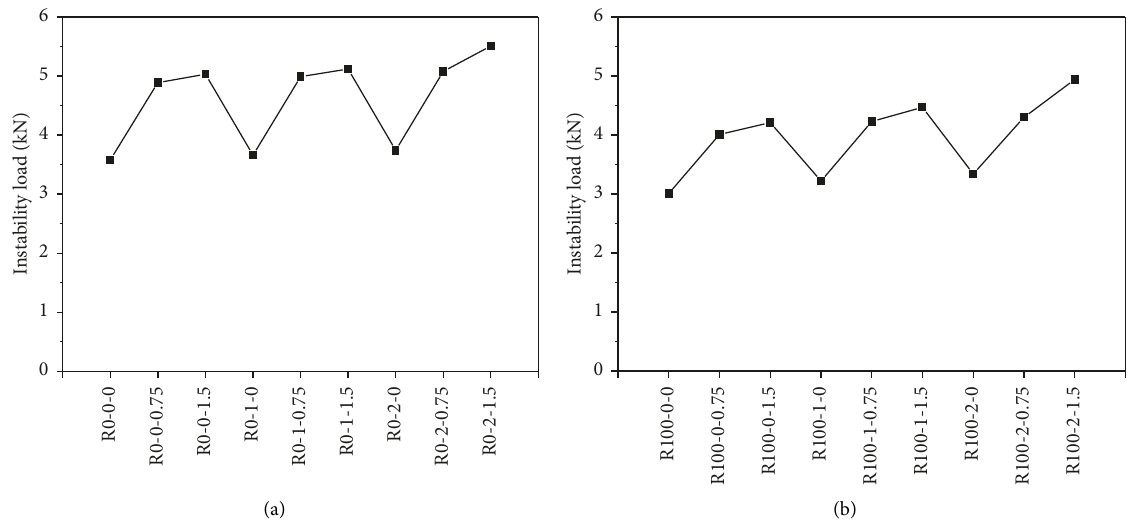
Figure 10: Instability load. (a) Replacement rate of 0%. (b) Replacement rate of 100%.